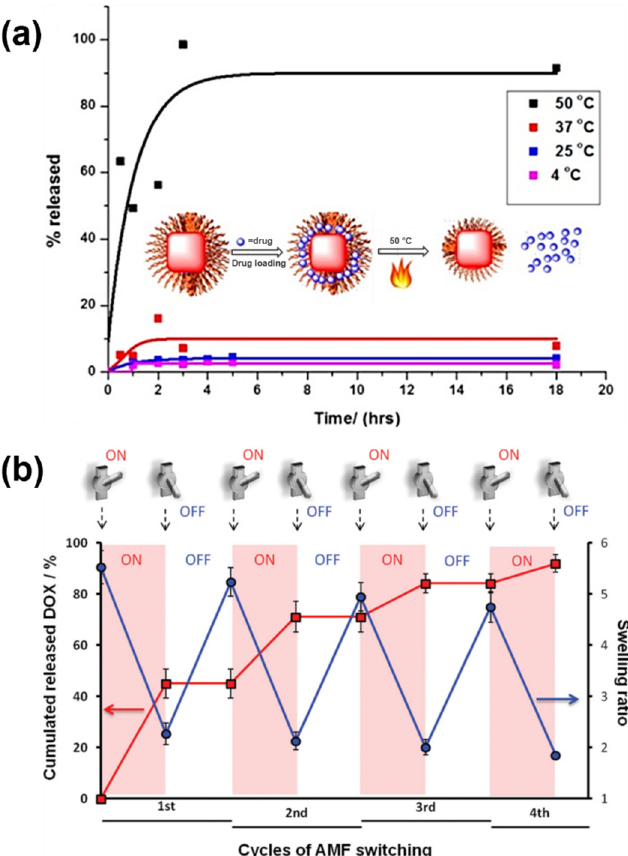
Figure 24. ( a ) Drug release from thermoresponsive PNIPAm-co-PEGA cubic-IONPs in a water bath at various temperatures (50 °C, black box; 37 °C, red box; 25 °C, blue box; 4 °C, purple box). Reproduced with permission from reference [92]. Copyright 2015 American Chemical Society. ( b ) ‘On– off’ switchable and reversible heat profile and swelling ratio of MNPs with crosslinked poly(NIPAm-co-HMAAm) nanofibers and the DOX release profile corresponding to the reversible swell–shrink property in response to temperature changes. DOX release = D released at X/D total × 100 (%); M released at X is the cumulative amount of released DOX at the X cycle of AMF alternation; and M total is the total amount of incorporated DOX in MNP-loaded nanofibers. Swelling ratio = (W swell − W dry )/W dry , where W swell is the weight of swelled MNP-loaded nanofibers and W dry is the weight of dried MNP-nanofibers. Reproduced with permission from reference [91]. Copyright 2013 John Wiley and Sons.